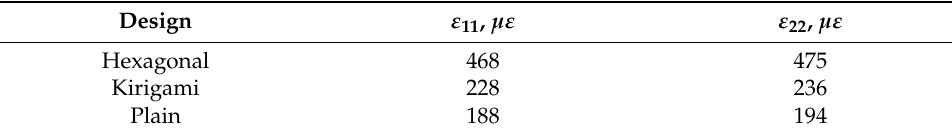
Table 6. Longitudinal and transverse strains for all simulated